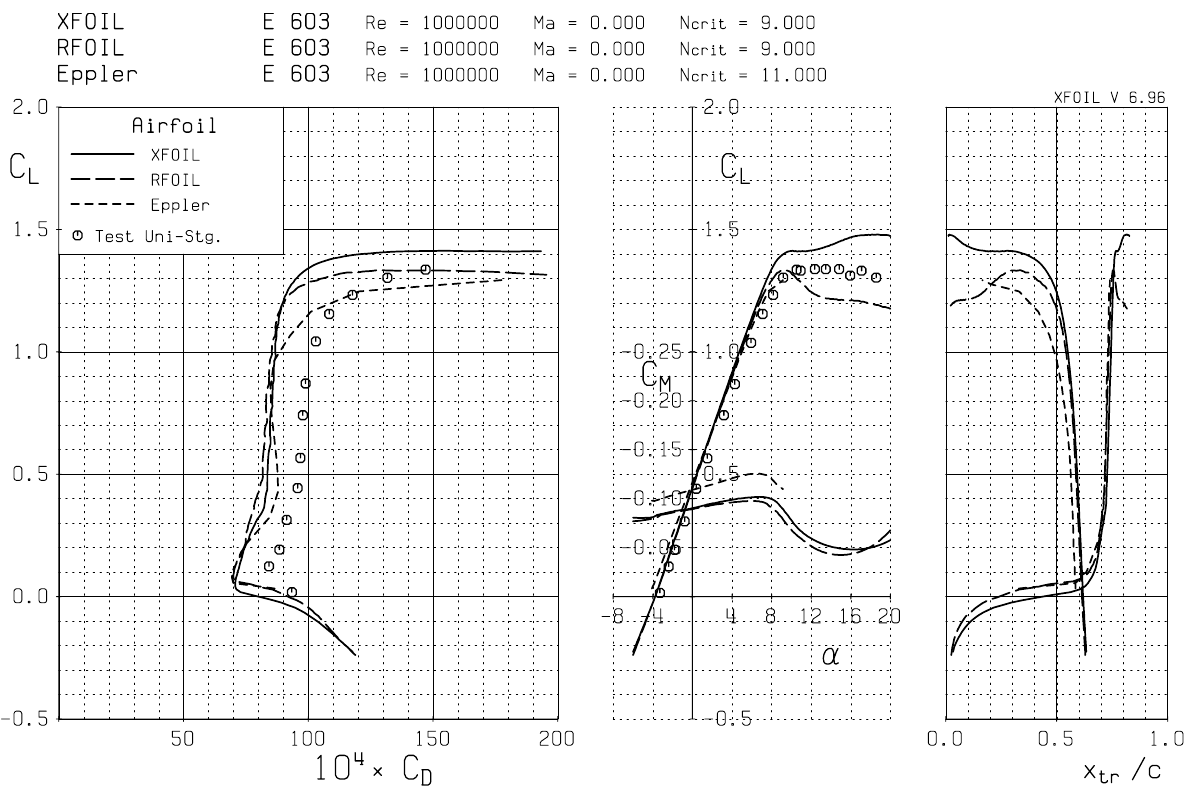
Fig 7. Comparison of calculated and measured data of E603 airfoil at Re = 1·10 6